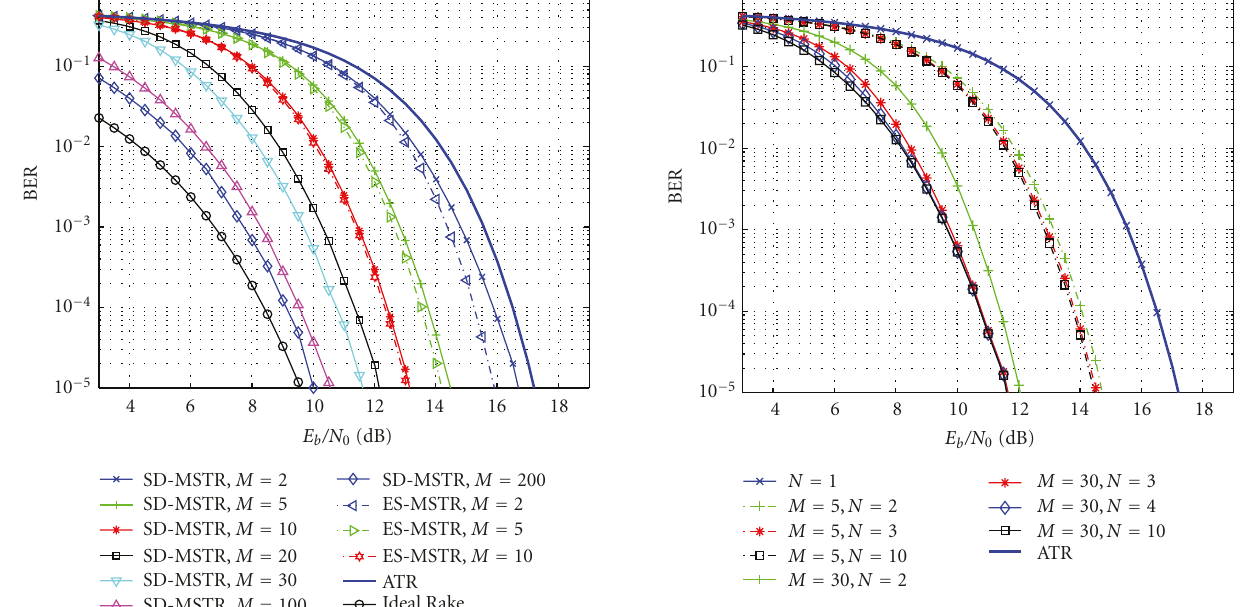
Figure 2: BER of SD-MSTR for di ff erent M , K = 200, N f = 20, N = 10 .